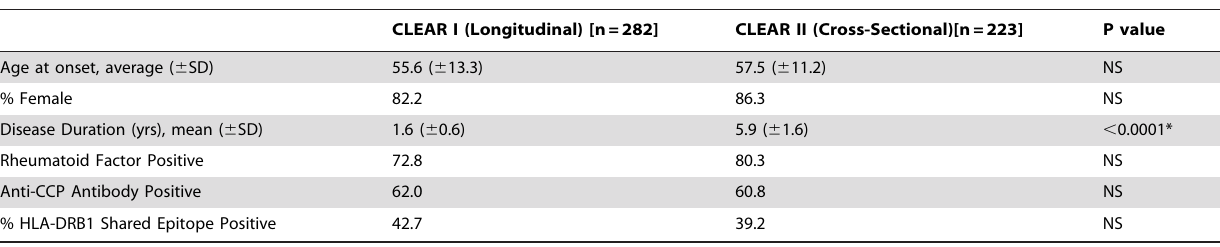
Table 1. Demographics of populations used in this study.